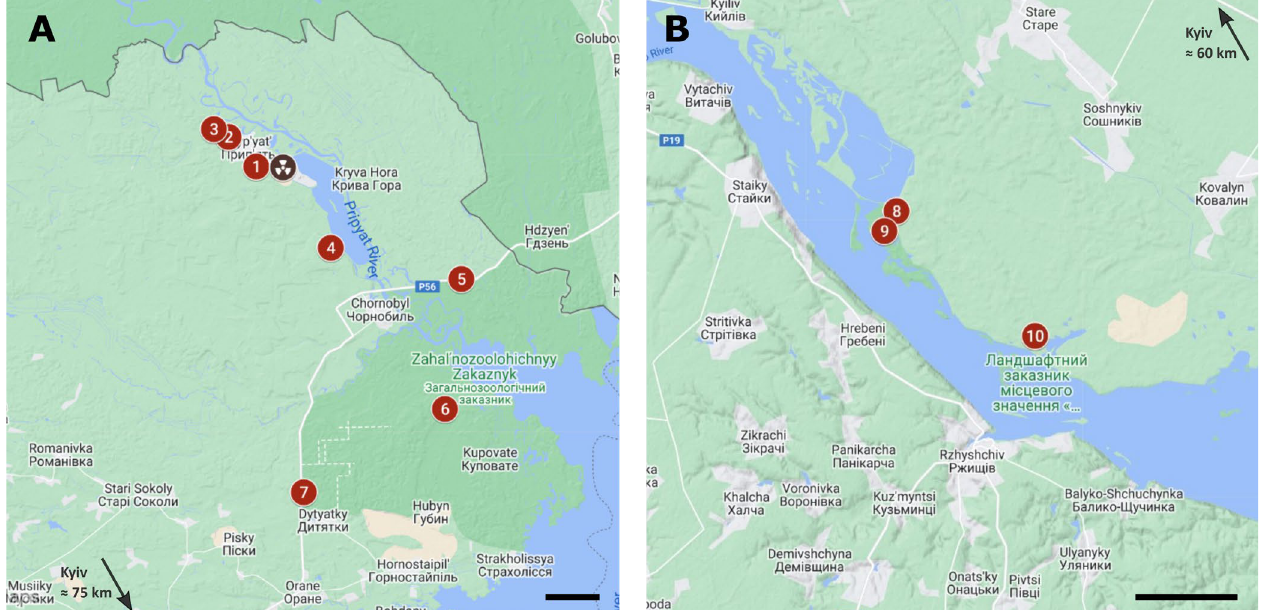
Figure 1. Fungi sampling sites within the Chornobyl exclusion zone ( A ) and Kyiv region ( B ). Scale bars represent 5 km (maps were created by Google My Maps (Google LLC)).